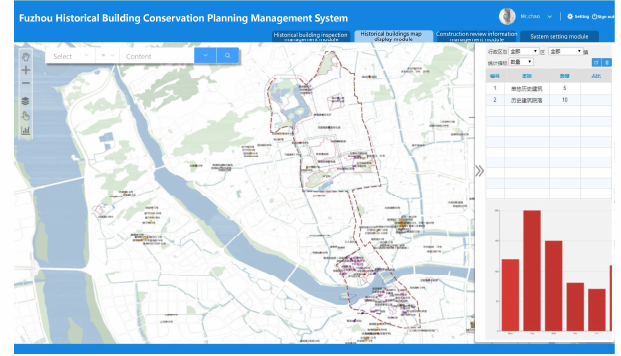
Figure 2. Statistics and analysis of historical